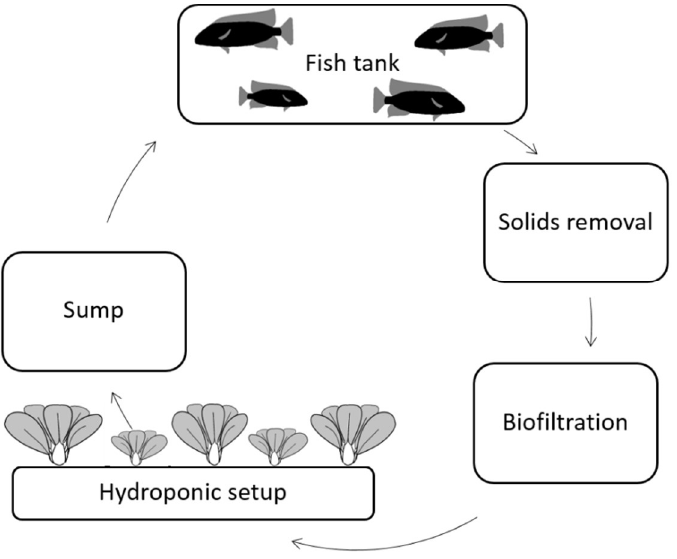
Figure 1. A schematic representation of an aquaponic system. The arrows indicate the water flow through the system.